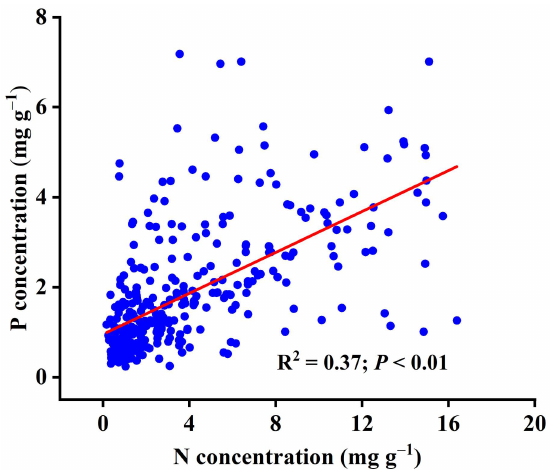
Figure 2. Correlation of N and P concentrations in leaves. Red solid line represents the significant correlation between leaf stoichiometry and geographical factors ( p < 0.05, p <